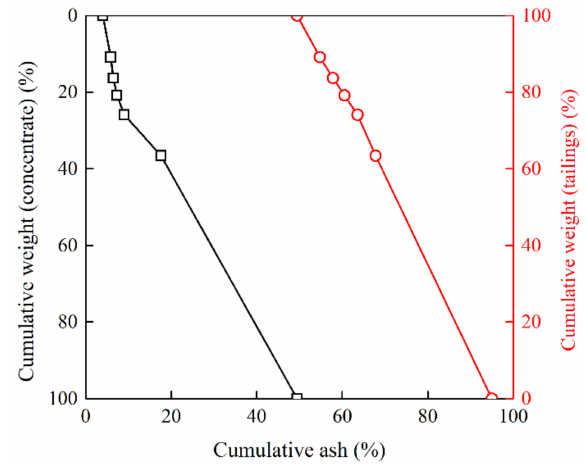
Figure 7. Classical floatability curves of <0.5 mm coal.